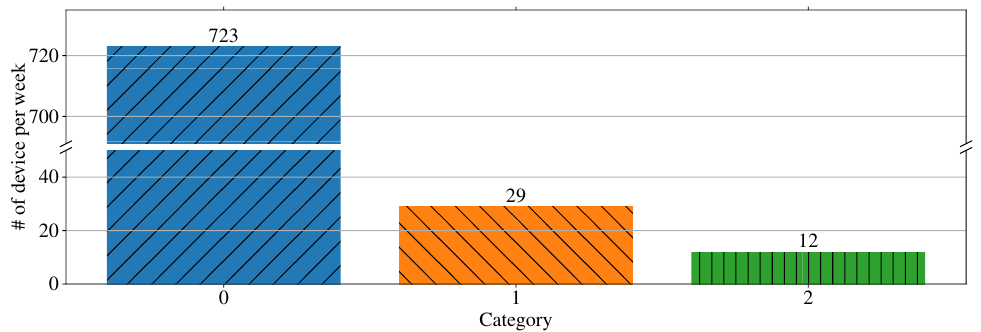
Figure 24. Device per week count on max(FFT) K-means cluster